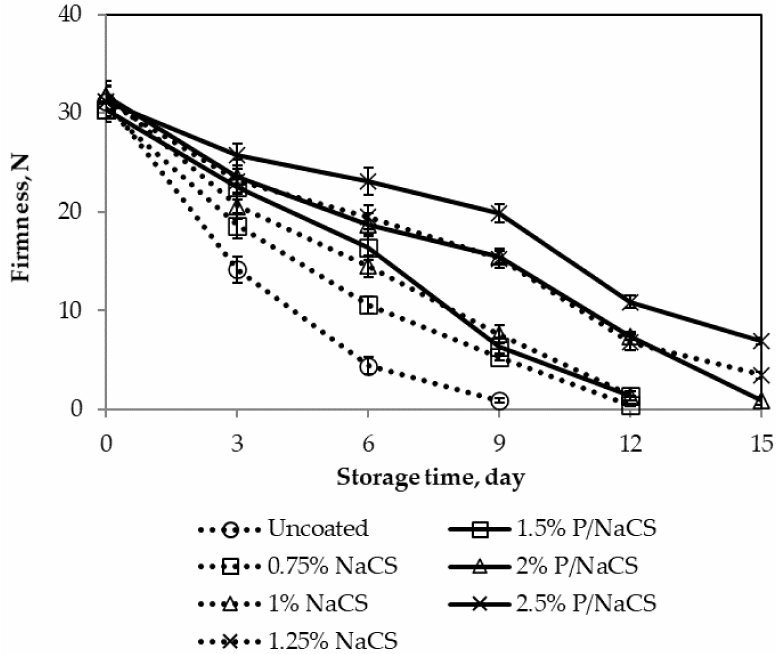
Figure 3. Effect of coating on firmness of mango fruits. Numbers are the mean ± standard errors of three